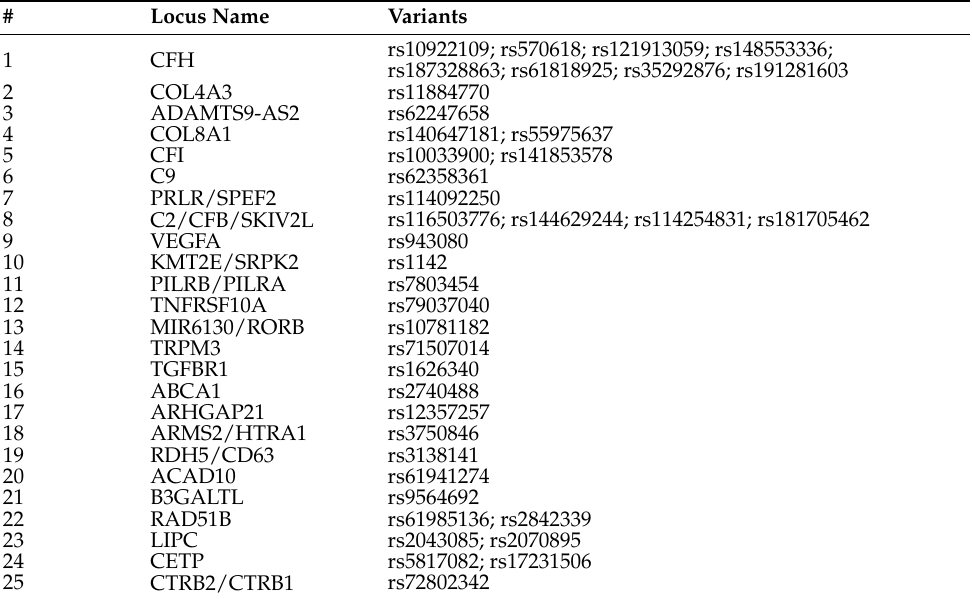
Table A1. A summary of the 52 independent AMD risk variants identified in 34